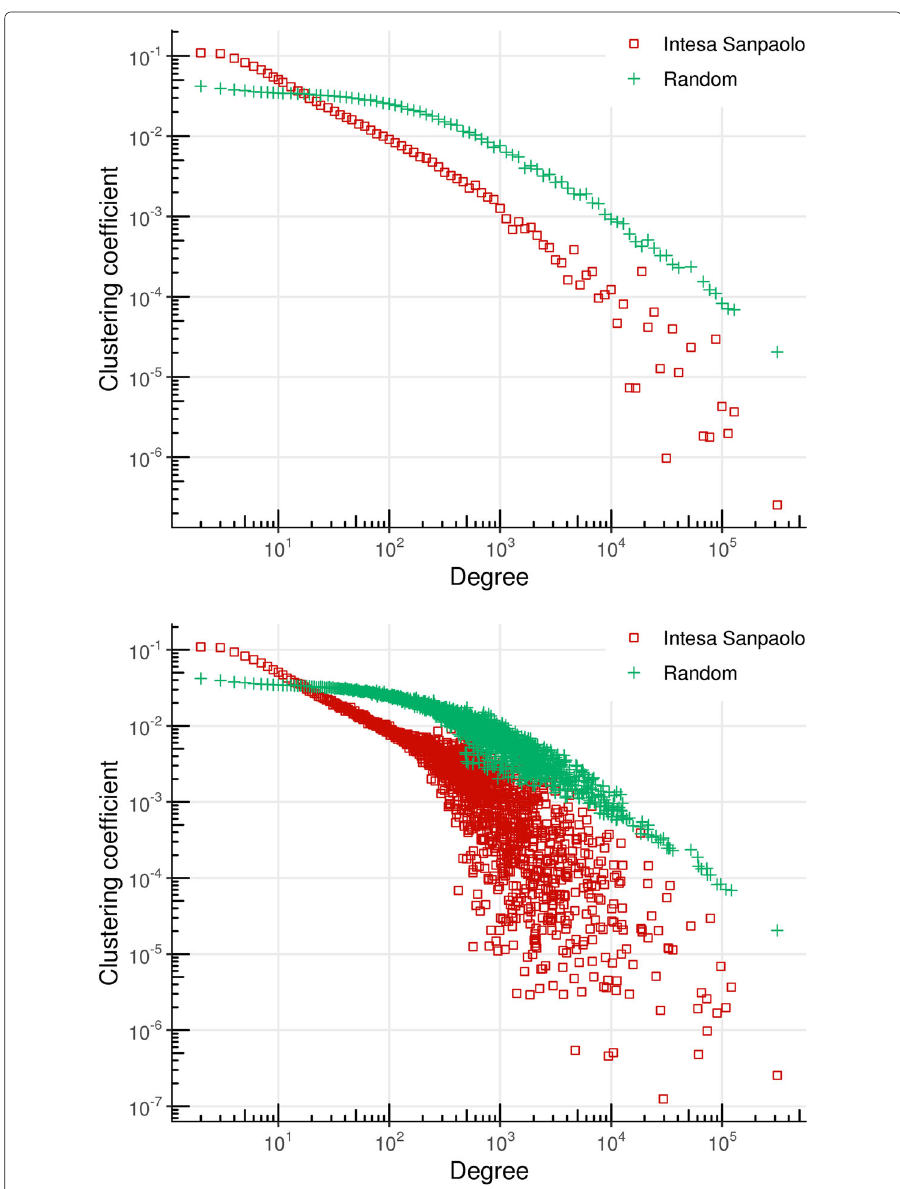
Fig. 9 Clustering coefficient as a function of the degree for the wire transfer network (red squares) and its randomised version (green crosses), on a log-log scale with (top) and without (bottom) logarithmic binning. We plot C k , that is the average clustering coefficient of all the k -degree nodes. Intesa Sanpaolo’s network shows a stronger dependency of the clustering coefficient on the degree of the nodes, as a result of a process driven by the reasons of the payments: natural persons (low degree, see Fig.6) pays each other in local communities and families, therefore many triangles are likely to be closed, while big companies (high degree) spreads their payments over different and distant receivers, without closing triangles so often